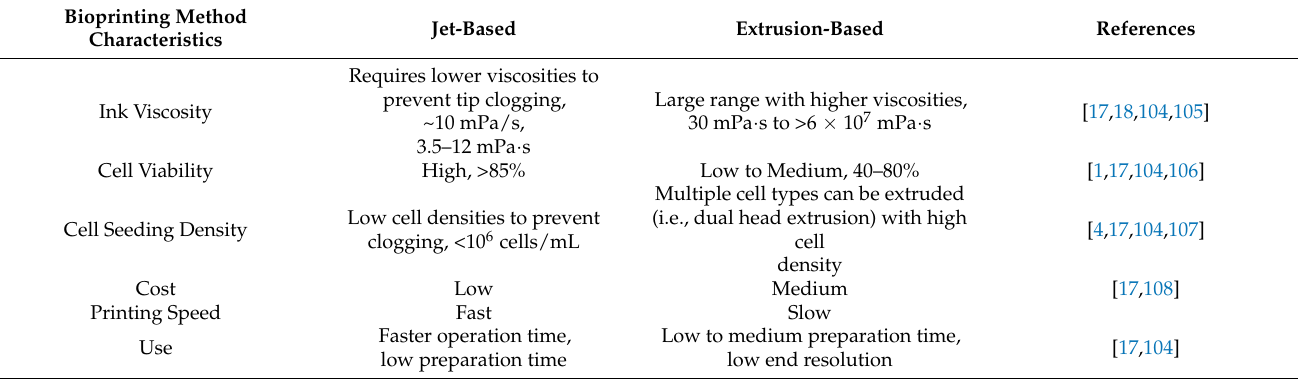
Table 2. Characteristics of jet-based and extrusion-based